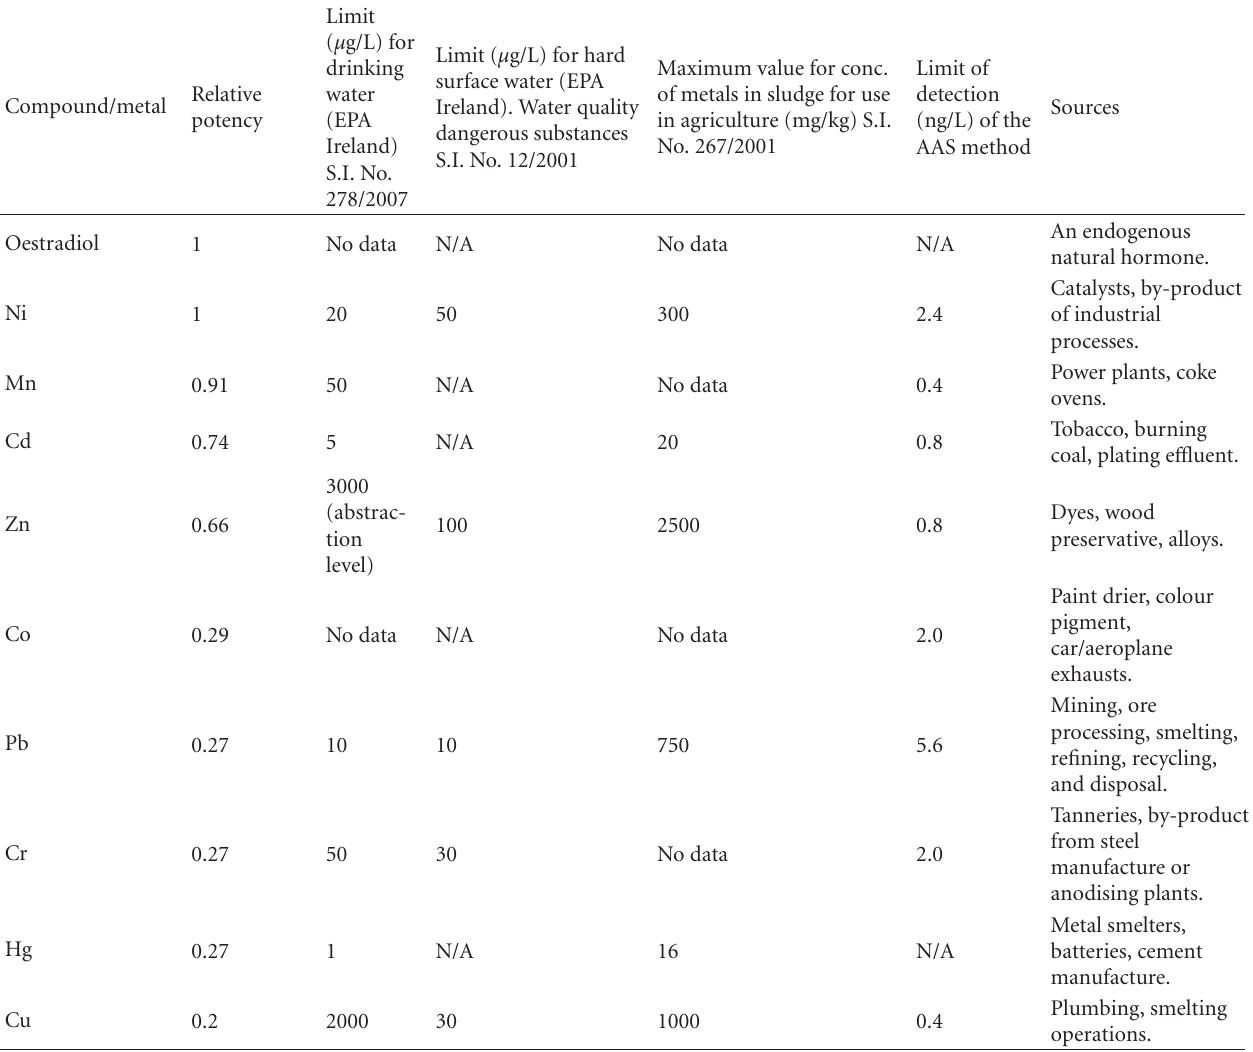
Table 1: Oestrogenicity of metals (data amalgamated from Choe, Martin, and EPA).